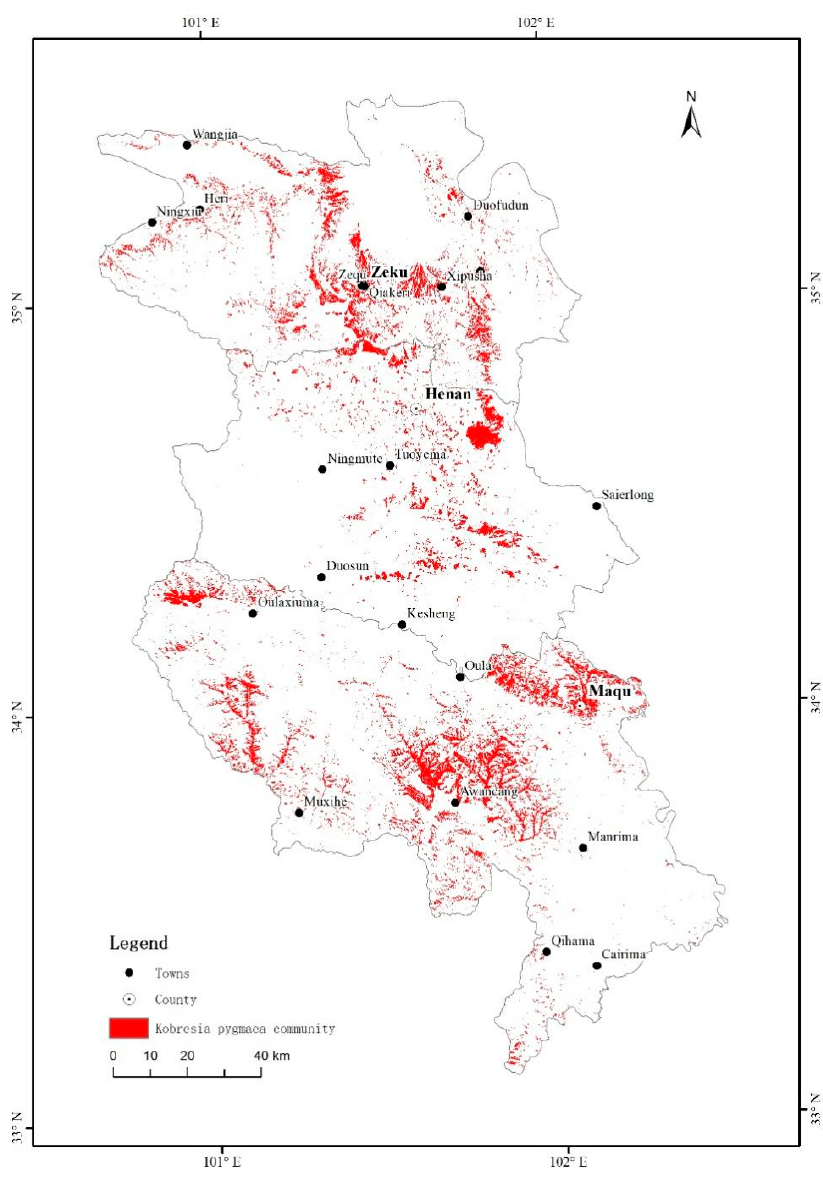
Figure 5. Distribution of Kobresia pygmaea community in Counties of Zeku, Henan and